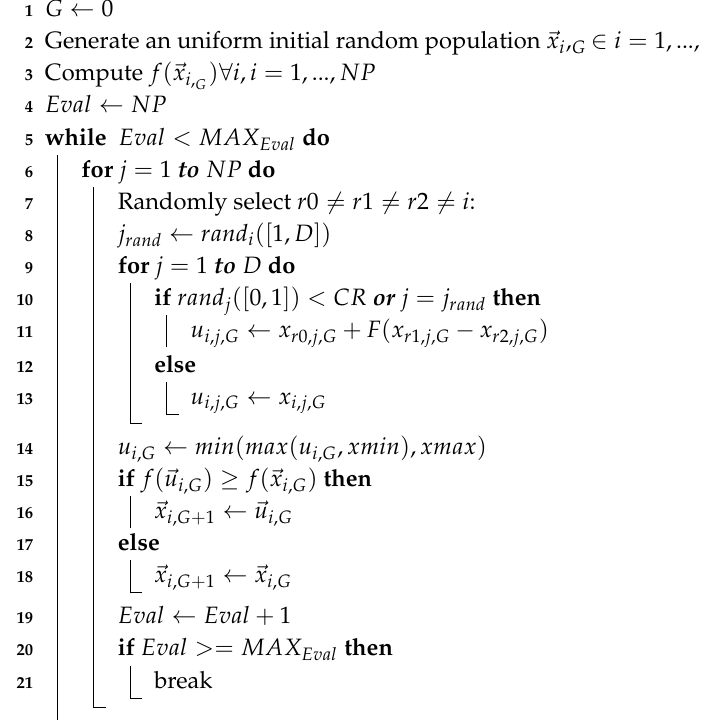
Algorithm 1: “DE/rand/1/bin” Algorithm. NP , MAX Eval , CR and F are parameters defined by the user. D is the dimension of the